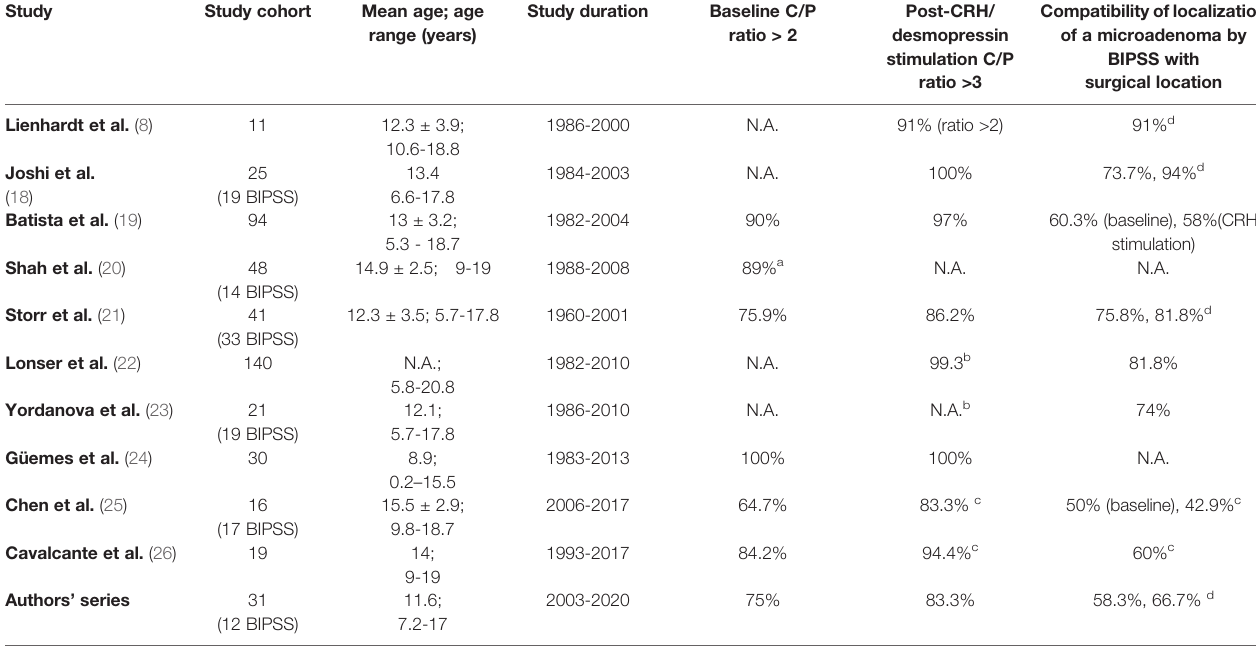
a baseline ratio criteria ≥ 2. b peak ratio criteria ≥